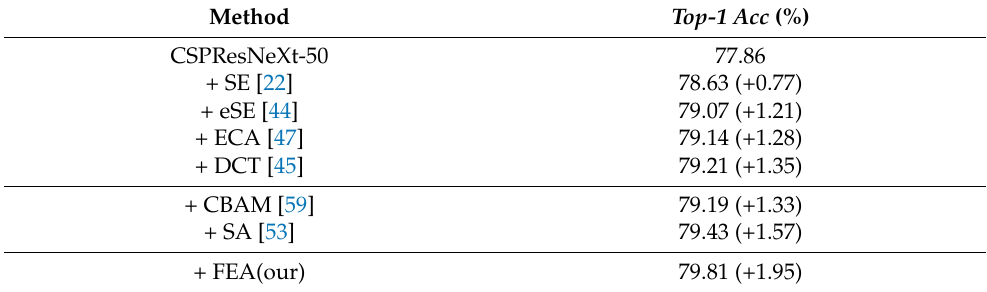
Table 3. Performance comparison of different attention methods on the CropDP-181